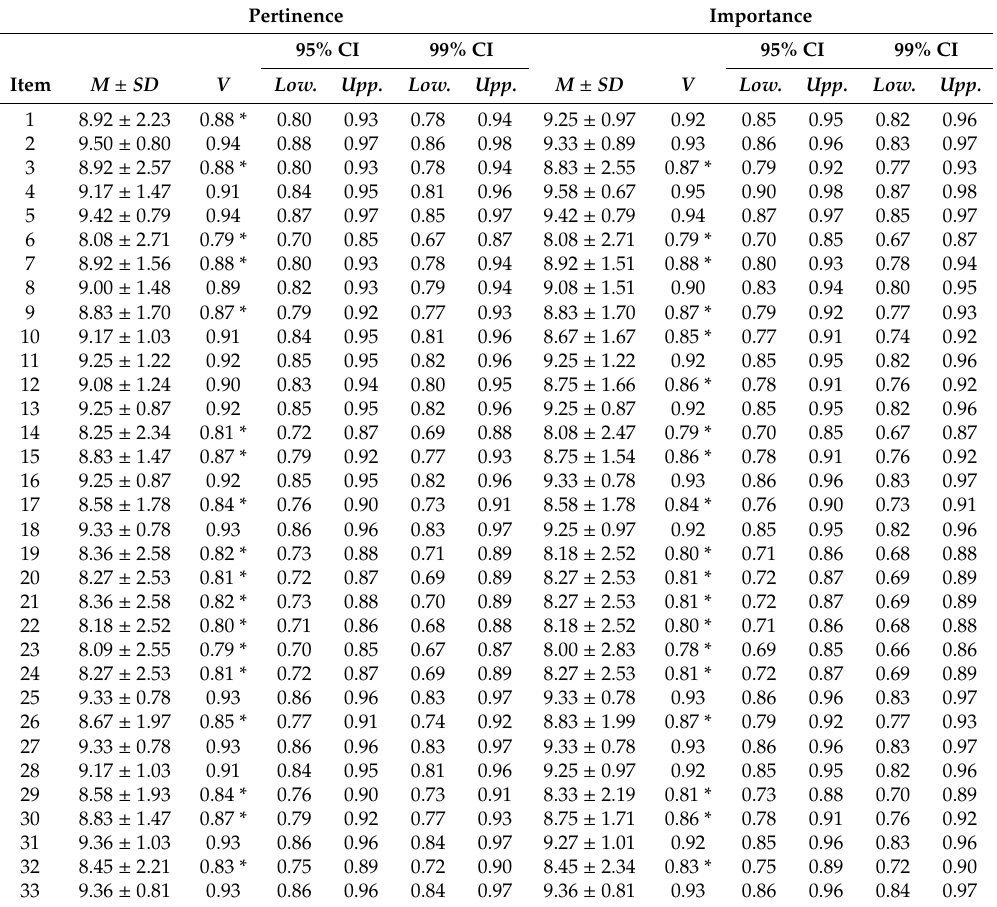
Table 5. Indexes of content validity (Aiken’s V ) and CI of 95% and 99% in the aspects of pertinence and